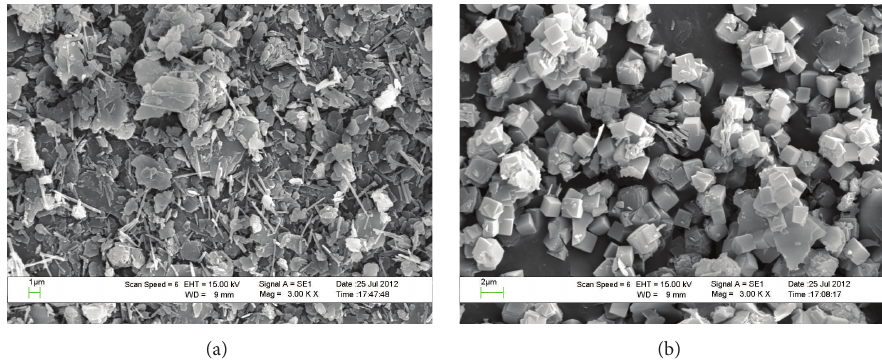
Figure 4: SEM photograph of clay (a) and zeolite-4A (b).